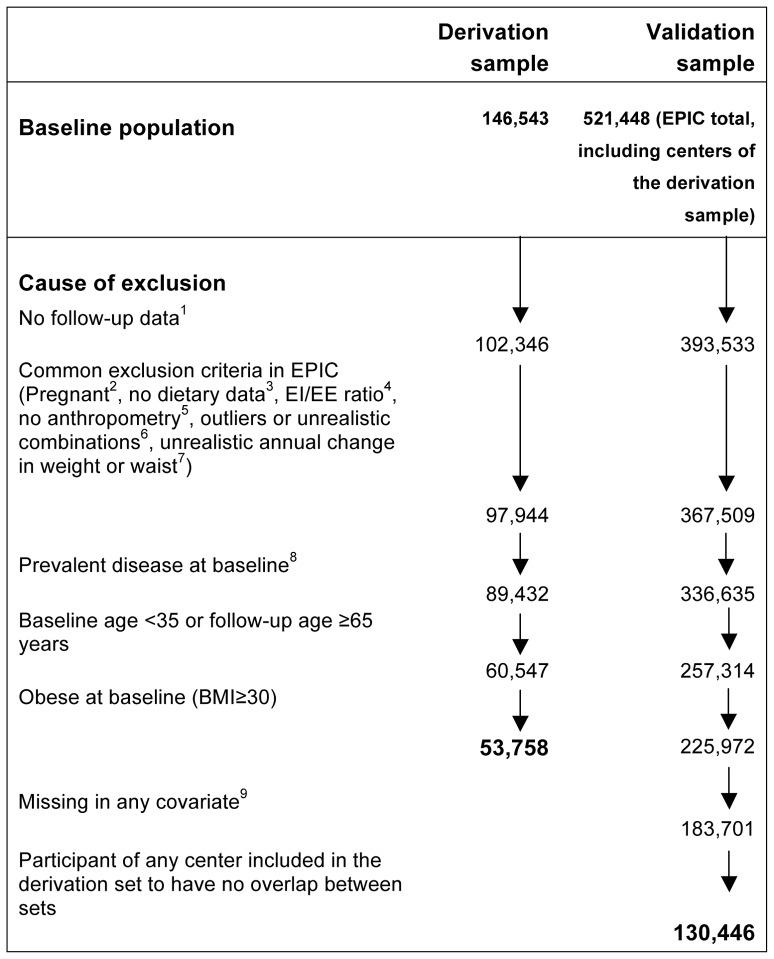
Flow diagram of participants excluded from the present study.
1No follow-up questionnaire (e.g. due to death before follow-up body weight assessment, not yet approached for follow-up body weight assessment, emigration or non-response to invitation). 2Pregnant at baseline or follow-up. 310% missing items on FFQ. 4Ratio of energy intake (EI) to energy expenditure (EE) estimated from predicted resting energy expenditure. 5Missing data on baseline or follow-up weight, waist or height, missing follow-up time. 6Baseline height<130 cm, BMI<16 kg/m2, 0<waist <40 cm, waist>160 cm, follow-up weight>700 kg. Combination of waist<60 cm and BMI>25 kg/m2. 7Annual weight change>5 kg (either direction) or annual waist change>7 cm (either direction). 8 Baseline cancer, diabetes or cardiovascular disease.9 In contrast to the derivation of the model where it is important to obtain unbiased estimates of relative risk, we think only original data should be used in the validation sample and we therefore excluded individuals with missing values.